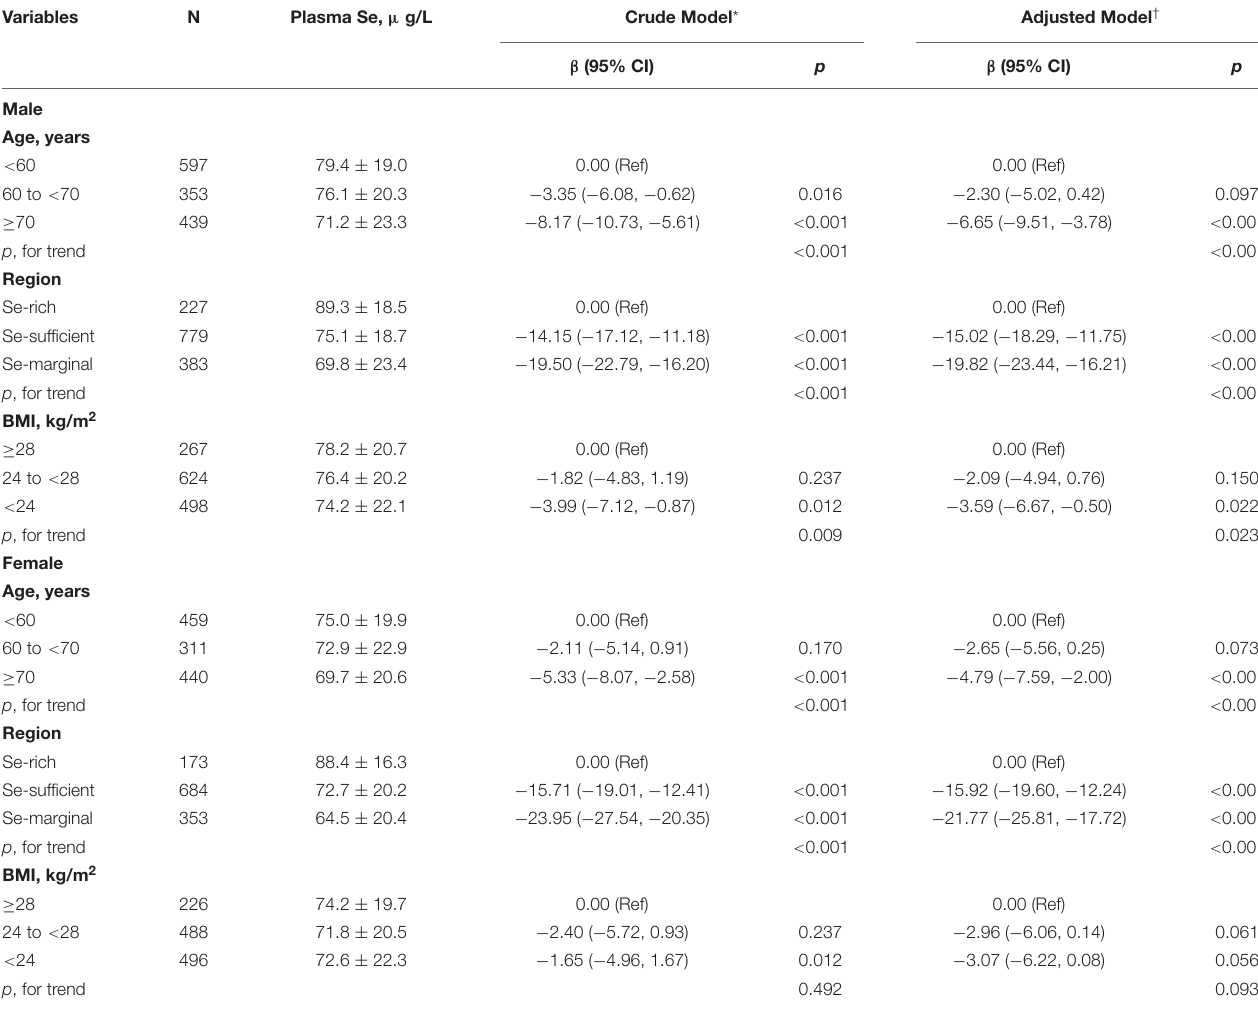
TABLE 2 | The β and 95% CI of plasma Se concentrations by demographic factors in Chinese middle-aged and elderly adults with hypertension stratified by sex.